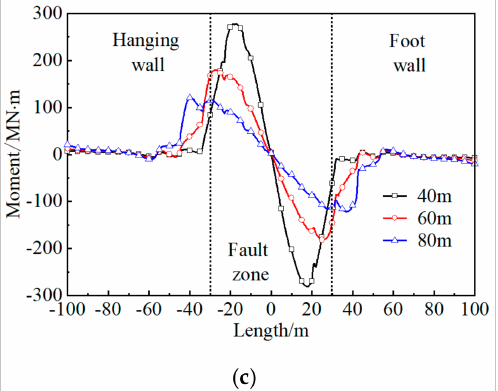
Figure 19. Distribution of internal force and moment for a tunnel under different fault widths. ( a ) equivalent axial force; ( b ) shear; ( c ) moment.